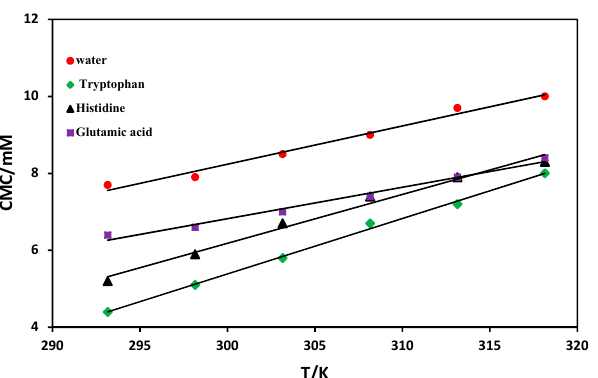
Figure 2. The CMC values of SDS in the presence and absence of amino acids as a function of temperature.